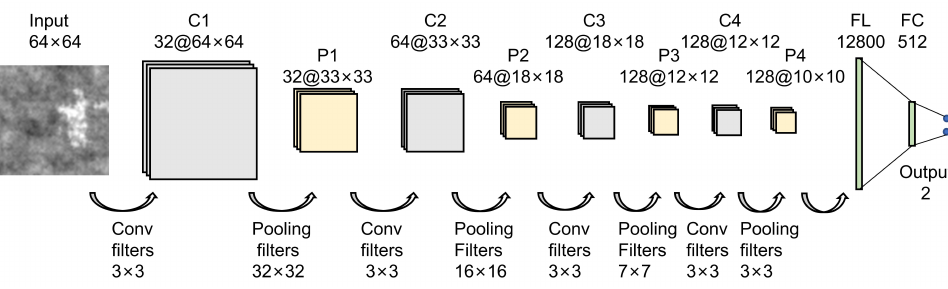
Figure 6. The architecture of our CNN networks for defect